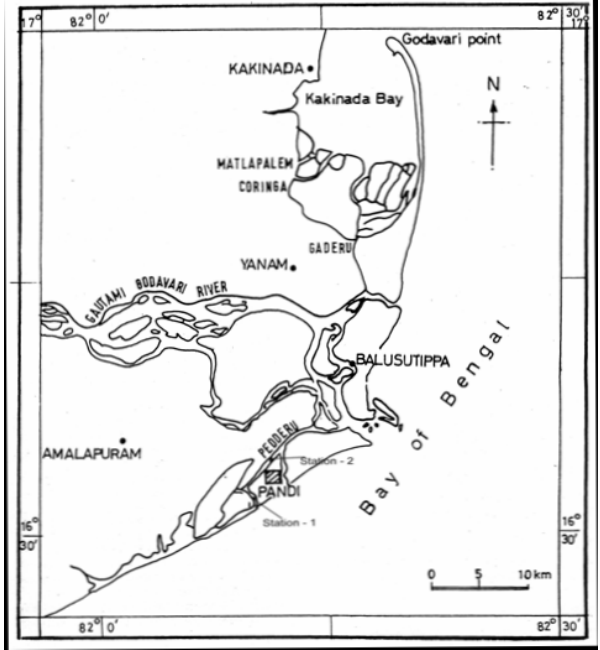
Fig. 1. Location map of the study